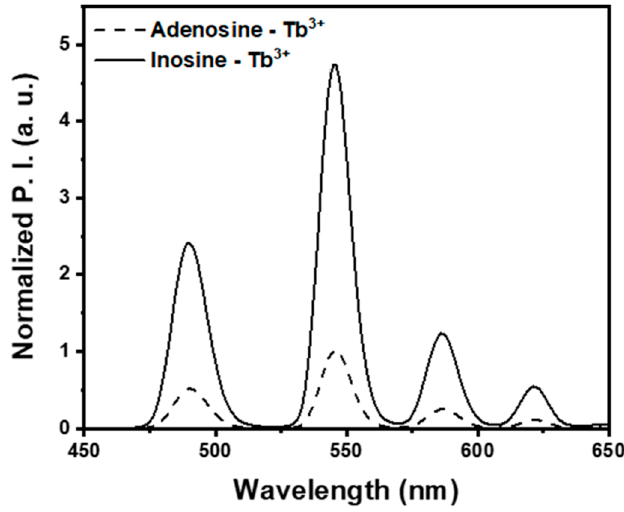
Figure 1. Comparison of luminescence of Tb 3 + (1 mM)-nucleoside (adenosine or inosine, 50 µ M) complex in HEPES buffer condition (pH 8.0; HEPES, 20 mM). λ ex = 260 nm.